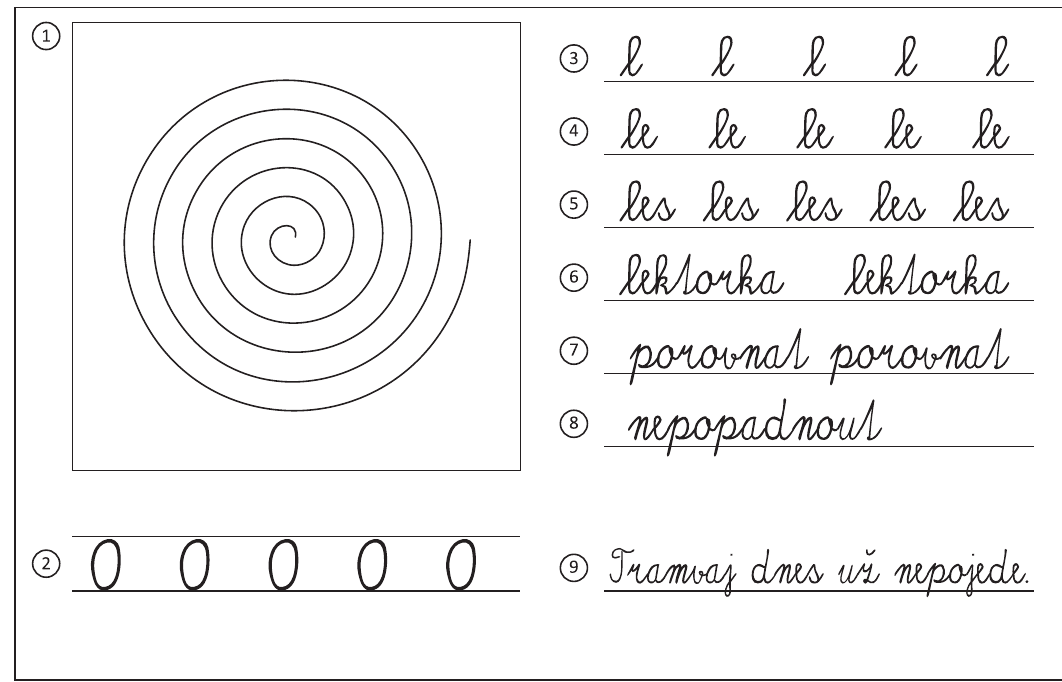
Figure 2. Filled template of the PaHaW database. Table 3. Description of the PaHaW handwriting